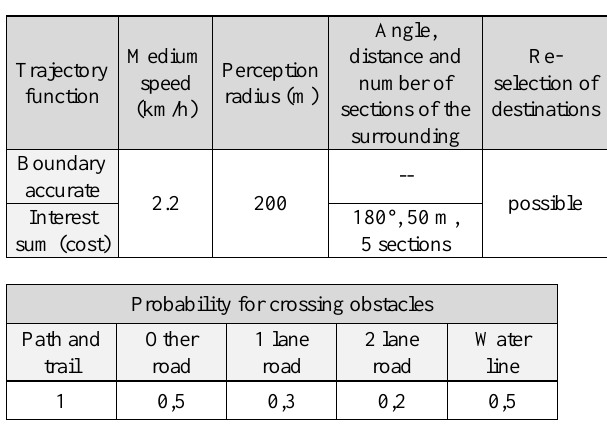
Table 2. Values of the parameters